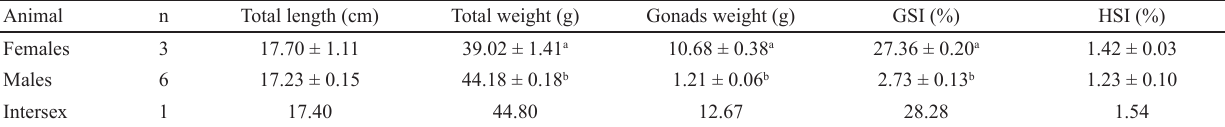
Table 1. Data on Steindachneridion parahybae juvenile’s biometrical parameters and gonadosomatic (GSI) and hepatosomatic (HSI) indexes at the Hydrobiology and Aquaculture Unit of Companhia Energética de São Paulo (CESP). Data are presented as the mean ± Standard error of the mean (M ± SEM). Values followed by different letters (a,b) are significantly different between sex (females or males) (P <